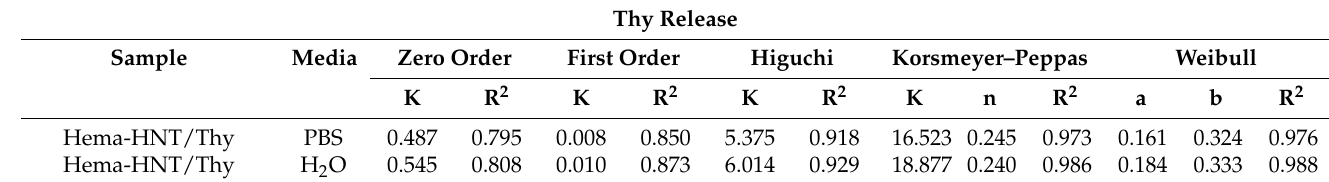
Table 1. Kinetic release parameters for Thy from cryogel samples in PBS and H 2